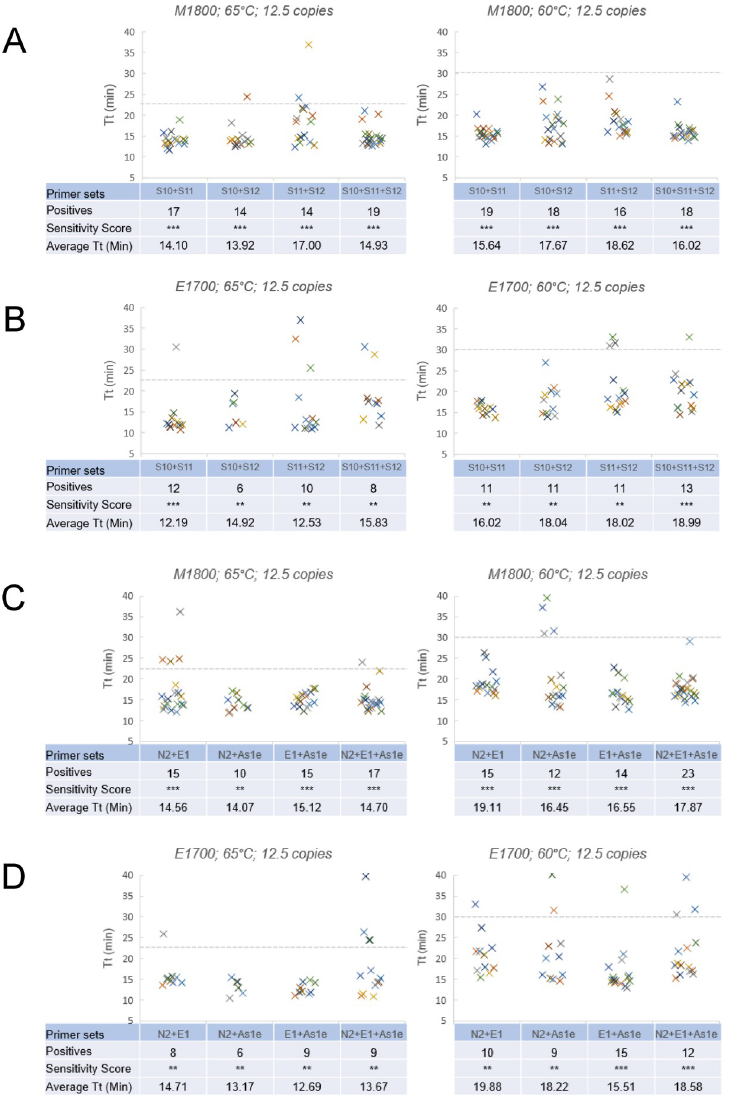
Fig 4. Effect of combining 3 primer sets. Detection sensitivity by a combination of 2 primer sets was compared with that by a combination of 3 primer sets in the presence of ~12.5 copies of template RNA per reaction in M1800 and E1700 at 65 and 60˚C. (A) Combinations of 2 primer sets for S10, S11 and S12 versus a combination of all 3 sets using M1800 at 65 and 60˚C. (B) S10, S11 and S12 in E1700 at 65 and 60˚C. (C) Combinations of 2 primer sets for N2, E1 and As1e versus a combination of all 3 sets using M1800 at 65 and 60˚C. (D) N2, E1 and As1e in E1700 at 65 and 60˚C. Sensitivity Score for 12.5 copies: ��� 12–24 positives; �� 6–11 positives; � 1–5 positives.